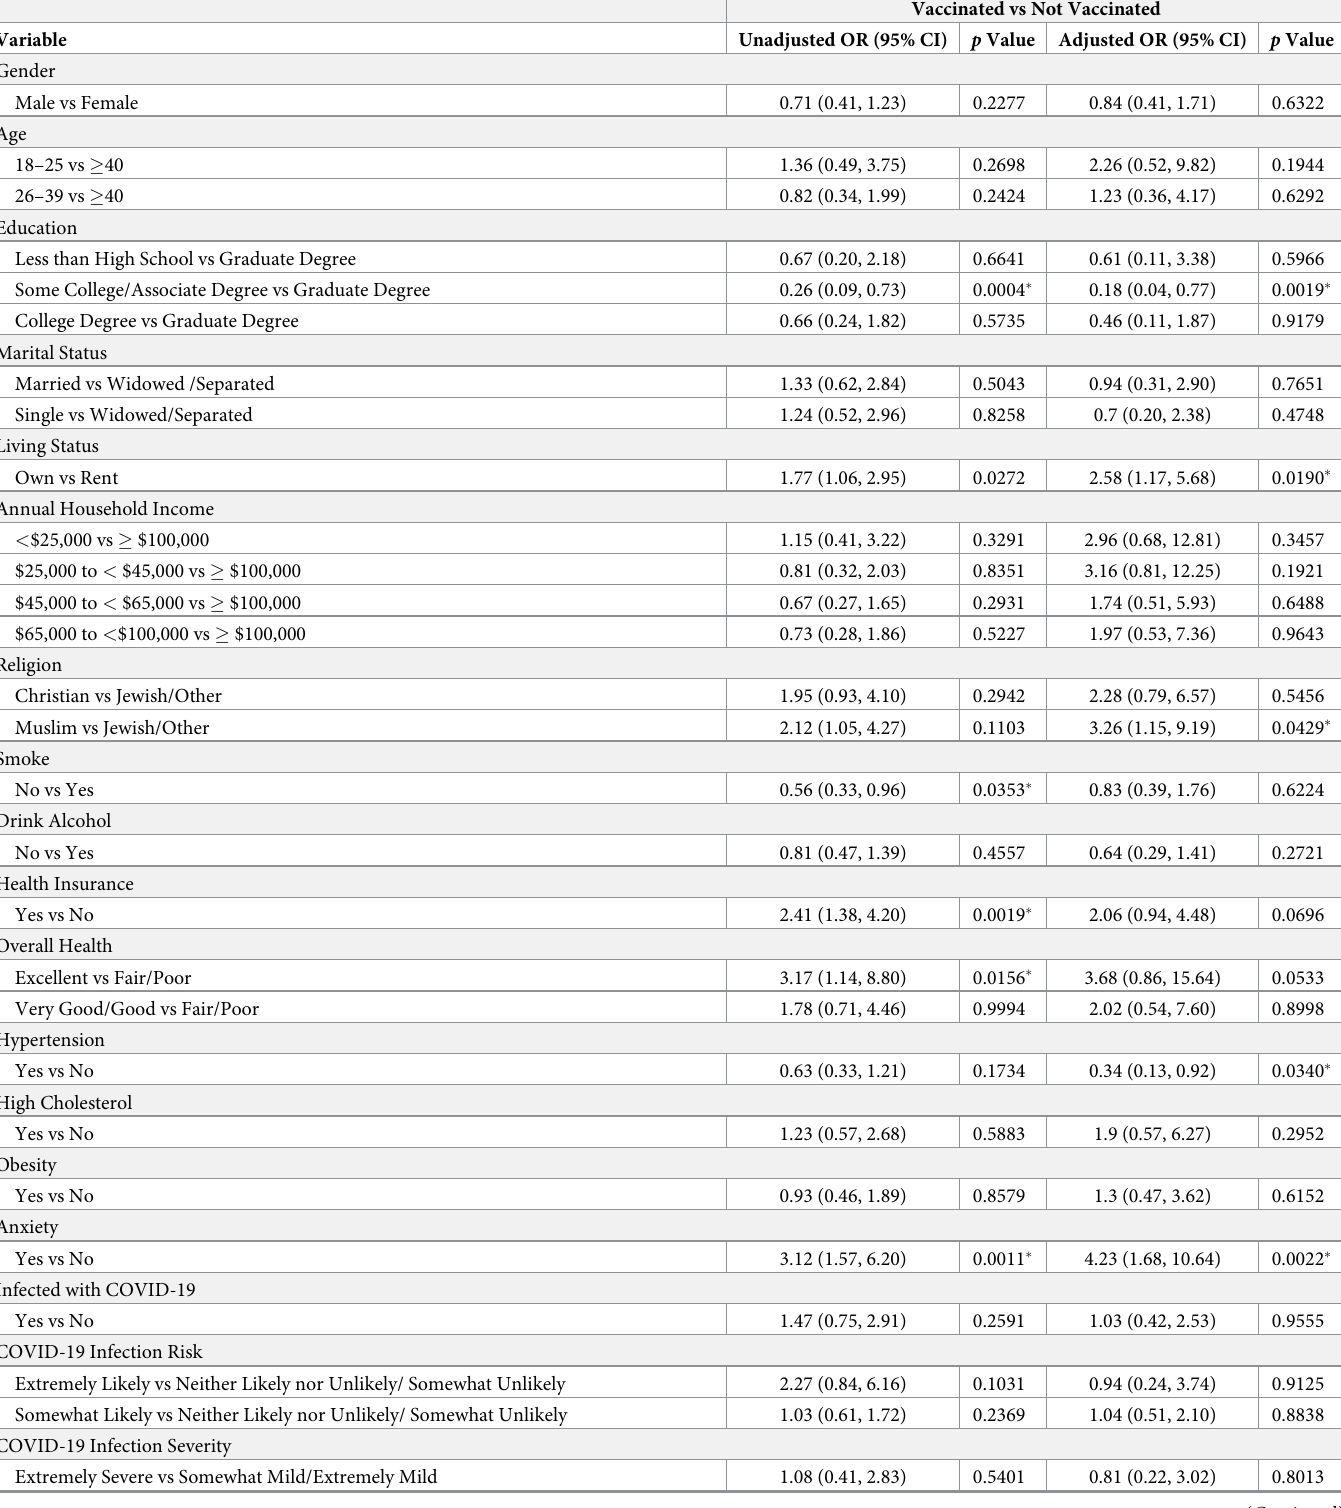
Table 3. Multivariable logistic regression of COVID-19